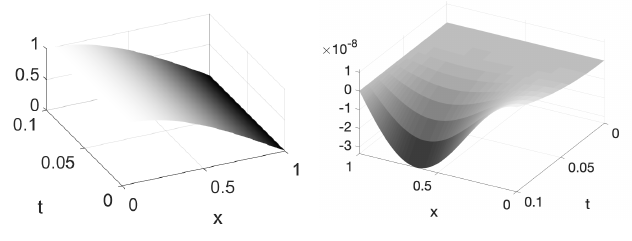
Figure 5. Numerical solution and the error of w ( x,t ) for ( x,t ) ∈ [0 , 1] × [0 ,T ] in example 2. α = 1 . 8, T = 0 . 1 and ∆t = 10 − 4 are used.